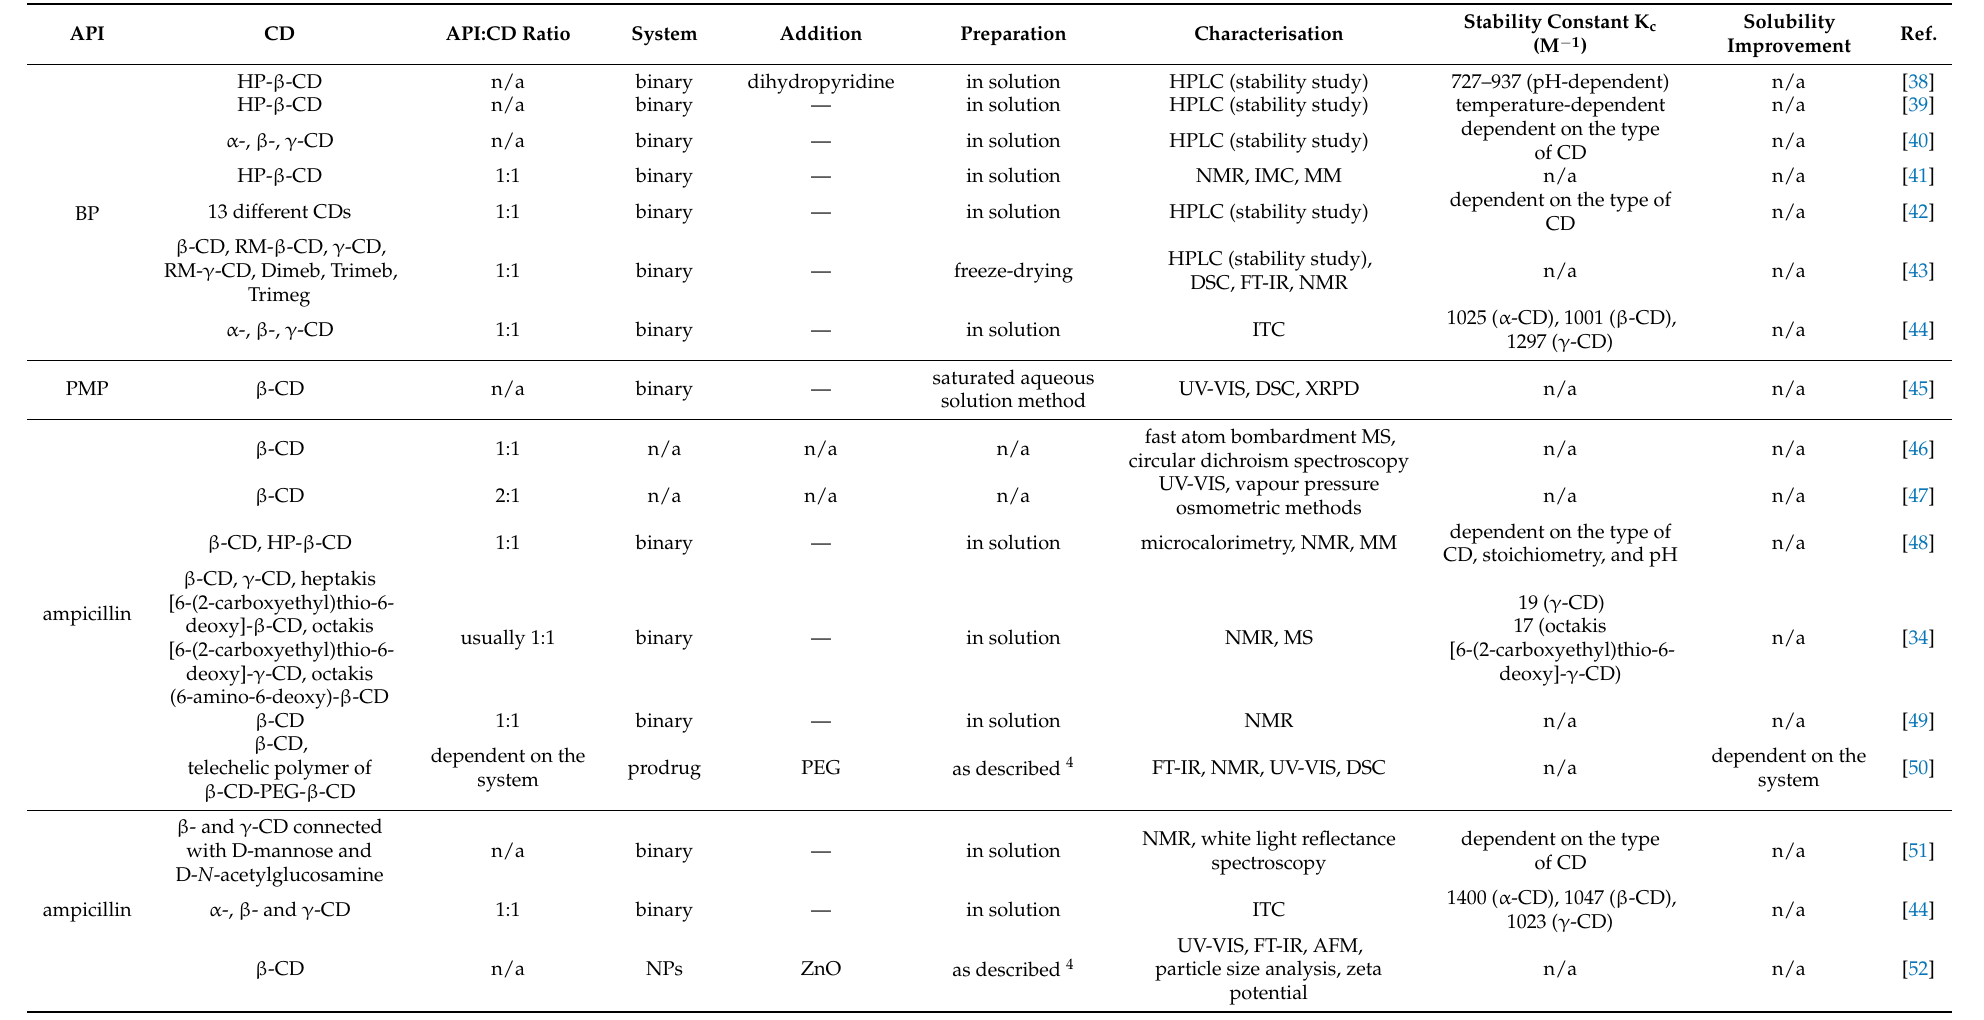
Table 1. Detailed information of penicillin complexes on the types of CDs used, methods of complex preparation, and techniques used to characterise the obtained products